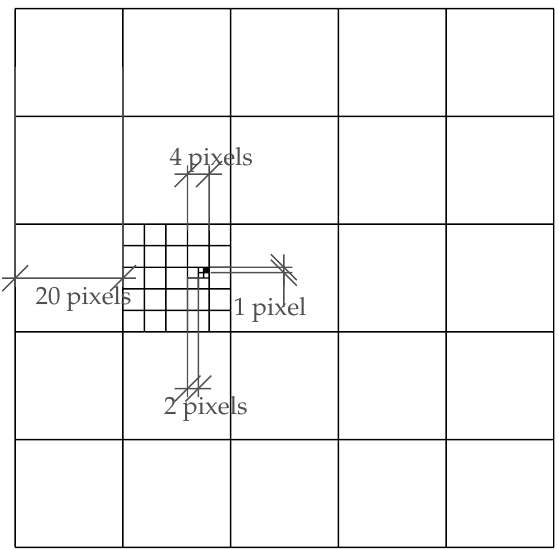
Figure 6. An example of the coarse-to-fine vanishing point fine-tuning process. The initial vanishing point is in the center. Every iteration reduces the span value and zooms in to a smaller area which has the lowest standard deviation (Equation (21)). This case reduced the calculation iteration from O ( n 2 ) ( 10,000 ) to O ( 1 ) ( 58 ) , significantly increasing the processing